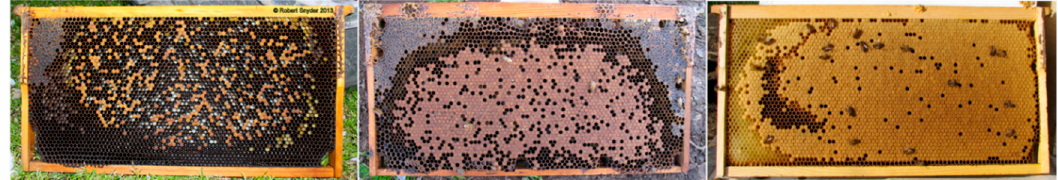
Figure 2. Sealed brood patterns rated a 1 ( left ), 3 ( middle ), and 5 ( right ). Photo credit: Rob Snyder.